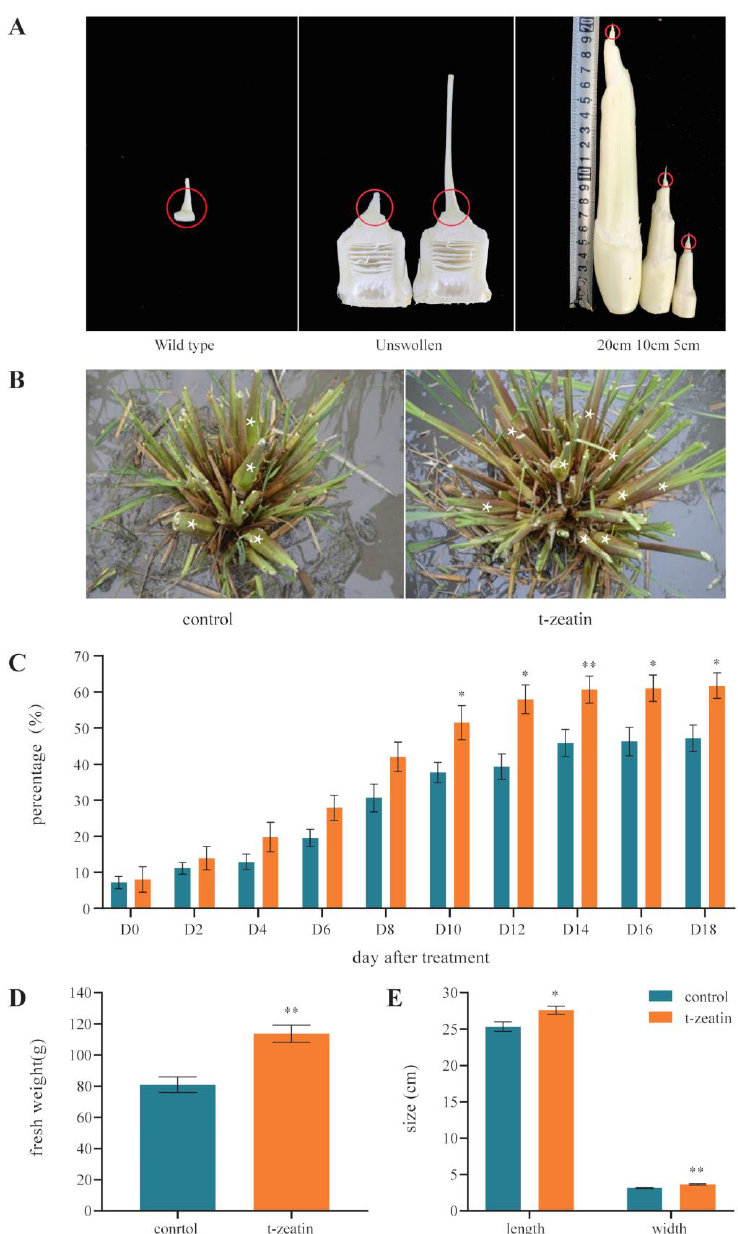
Figure 1. Development of and e ff ects of cytokinin on Zizania latifolia galls. ( A ) In contrast to uninfected wild-type (WT) shoots (left panel), infected shoots develop large galls under their apices up to 20 cm length, over a time course of 2 weeks (middle, initial shape of apex, right panel stages of gall formation). The red circles indicate the size of the collected samples collected for expression analysis. ( B ) Morphology (stars label the swollen shoots) and ( C ) frequency of gall formation of 150 mg / L t-zeatin treated and untreated Z. latifolia plants ( n = 12). ( D ) Fresh weight and size ( E ) of treated and untreated galls ( n > 100). Each histogram represents the mean value and the bar indicates the means ± standard error of biological replicates. * Significant di ff erence at p < 0.05. ** Significant di ff erence at p <